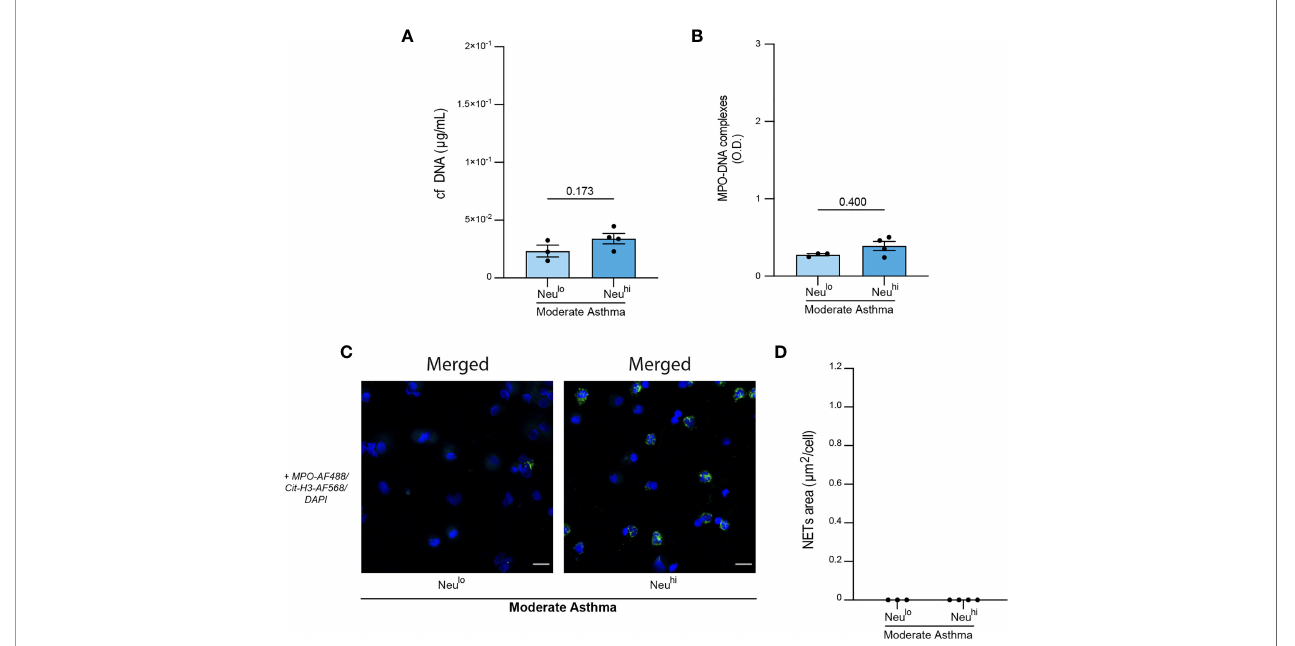
FIGURE 5 | Evidence that BALF neutrophils from moderately asthmatic neutrophilic horses release minimal amounts of NETs. (A) BALF cf DNA content measured by PicoGreen assay. (B) BALF MPO-DNA complexes measured by ELISA. (C) Representative confocal microscopy pictures of BALF cytospins stained with anti-MPO, anti-Cit-H3 antibodies, and DAPI. (D) NETs quanti fi cation in BALF cytopsins expressed as NETs area per cell. Data show mean +/- s.e.m., as well as individual horses (non-neutrophilic moderate asthma [Neu lo ] n=3; neutrophilic moderate asthma [Neu hi ] n=4). P values were estimated with a two-tailed unpaired Student t -test. (C) Scale bars = 20 µm; objective: